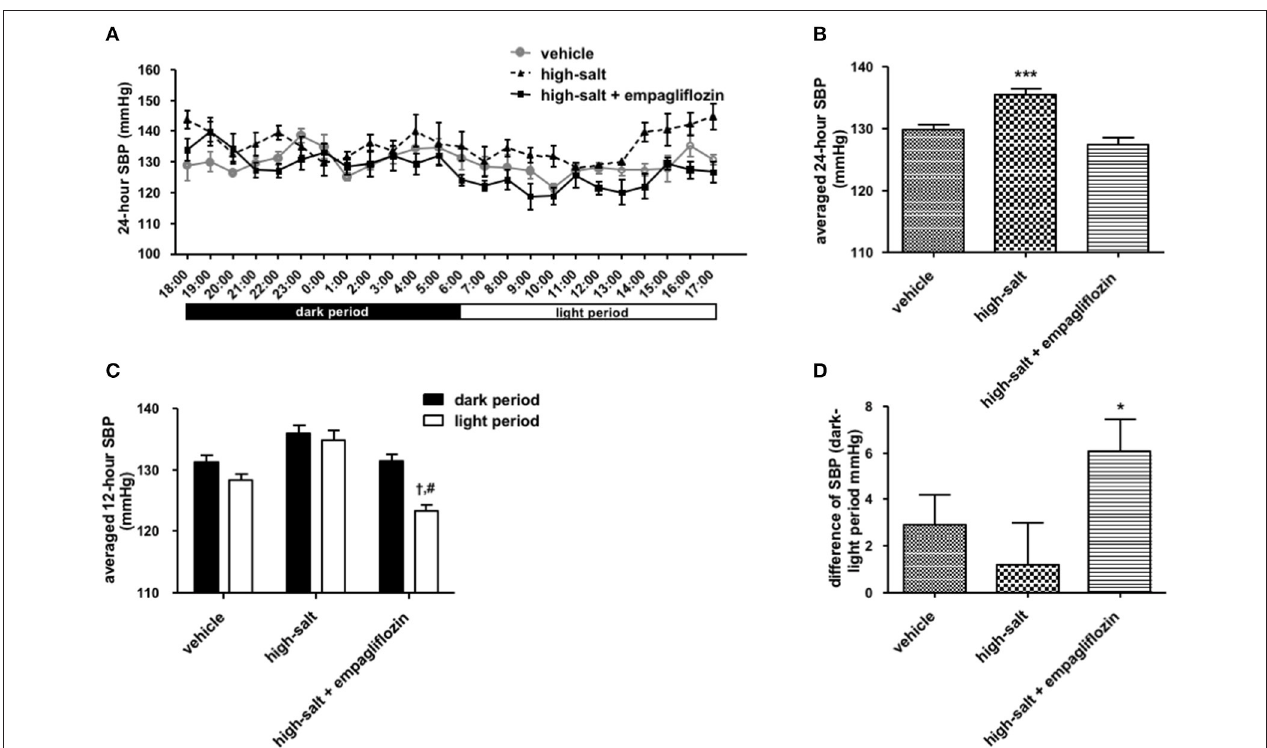
FIGURE 1 | Effects of empagliflozin treatment on systolic blood pressure (SBP), and on circadian rhythm of SBP, in Otsuka Long Evans Tokushima Fatty (OLETF) rats. (A) 24-h SBP. (B) Average of 24-h SBP. (C) SBP in dark and light periods. (D) Differences between dark and light period in SBP. OLETF rats were treated with vehicle (vehicle, n = 7), 1% NaCl drinking water (high-salt, n = 5), or 1% NaCl drinking water and empagliflozin (high-salt + empagliflozin, n = 8), for 5 weeks. Values are mean ± SEM. *** P < 0.0001 vs. vehicle and high-salt + empagliflozin (one-way analysis of variance followed by Tukey’s multiple comparison test), † P < 0.0001 vs. high-salt + empagliflozin dark period (2-way analysis), # P < 0.0001 vs. high-salt light period ( t -test), * P < 0.05 vs. high-salt ( t